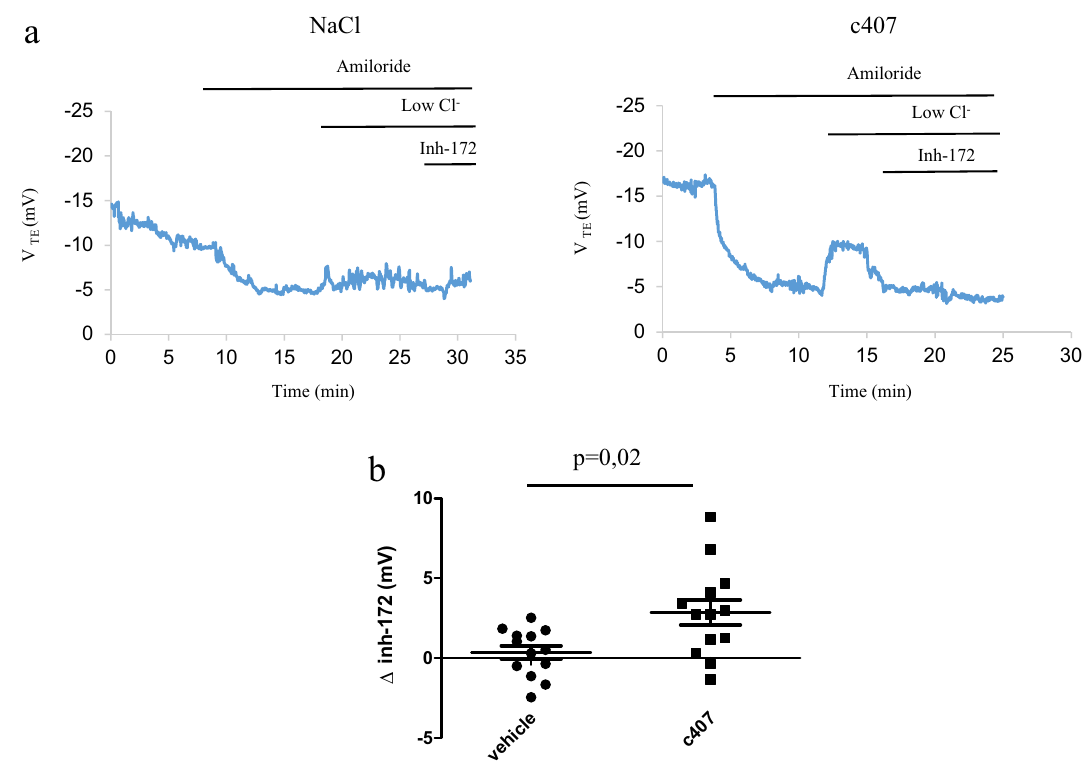
Figure 1. Effects of topical administration on Nasal Potential Difference in F508del Cftr tm1Eur mice. ( a ) Tracing of Nasal Potential Difference performed in a F508del Cftr tm1Eur mouse after topical instillation once a day for 48 h of NaCl 0.9% (left panel) or NaCl 0.9% followed by c407 10 µM (right panel). ( b ) Summary of Nasal Potential Difference changes after perfusion of Inh-172 5 µM in low Cl − solution (∆ Inh-172) in mice treated with NaCl 0.9% (n = 13) or NaCl 0.9% followed by c407 10 µM (n = 13).